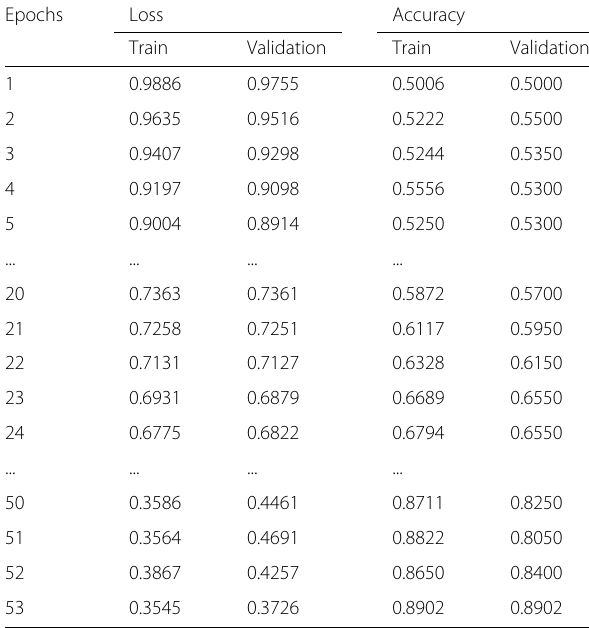
Table 4 Results of train and validation in ConvLSTMConv